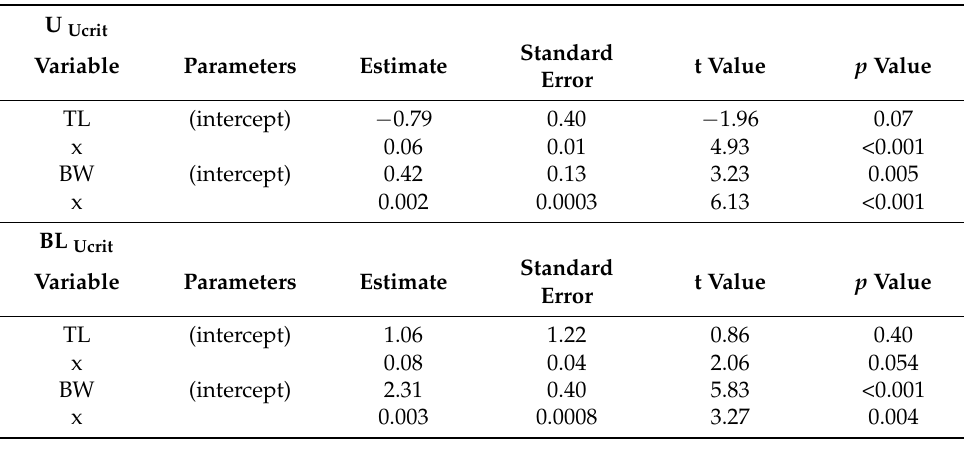
Table 1. Results of the different linear regression analyses between U crit and total length (TL), and body weight (BW) and between BLU crit and TL, and BW in rainbow trout ( Oncorhynchus mykiss ; n = 20 fish). Estimate ± standard error of the intercept and coefficient, t value and p value are provided for each linear regression. R 2 and p value for each significant linear regression are provided in the main